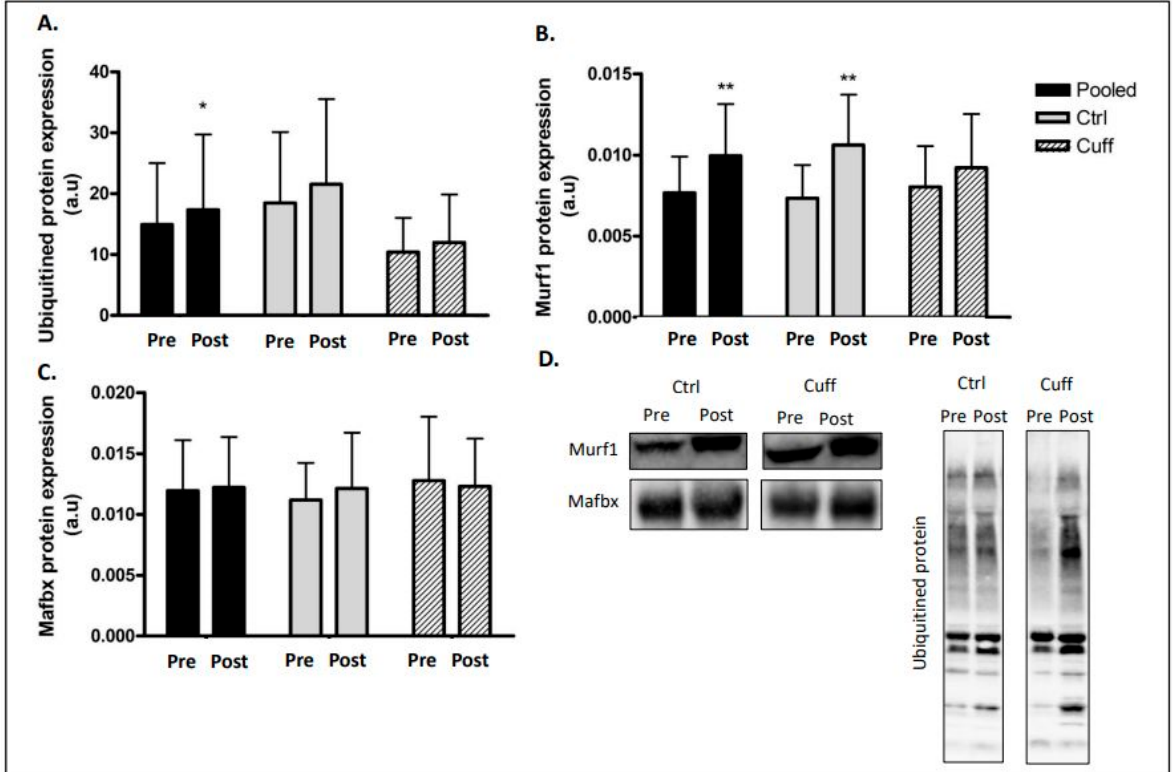
Figure 5. Effect of 5 days of DI on ubiquitin proteasome pathway. UPS marker activation access by western blot analysis. ( A ) Ubiquitinated protein profile expression. ( B ) E3 ligase Murf1 protein expression. ( C ) E3 ligase Mafbx (Atrogin1) protein expression. ( D ) Western blot picture analyzed by groups. * different from pre value in the same group. * p < 0.05; ** p < 0.01.